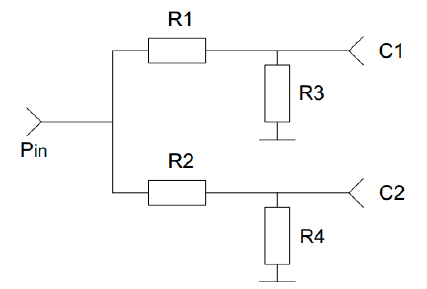
Fig. 5. Resistive power divider